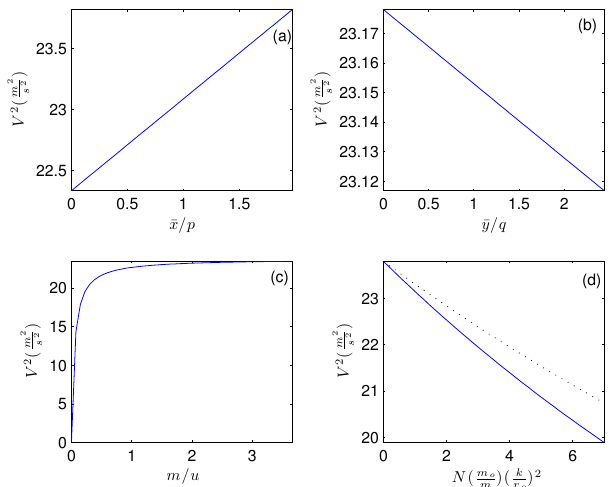
Figure 2. Energy balance trends showing the trends in v 2 while varying ¯ x (a) , ¯ y (b) , m (c) , and wheel parameters (d) . The dotted line in (d) represents a car with three wheels contacting the track or N = 3. The parameters listed in Table 1 and the normalization constants p = 0 . 09m, q = 0 . 013m, and u = 0 . 1091Kg were used.